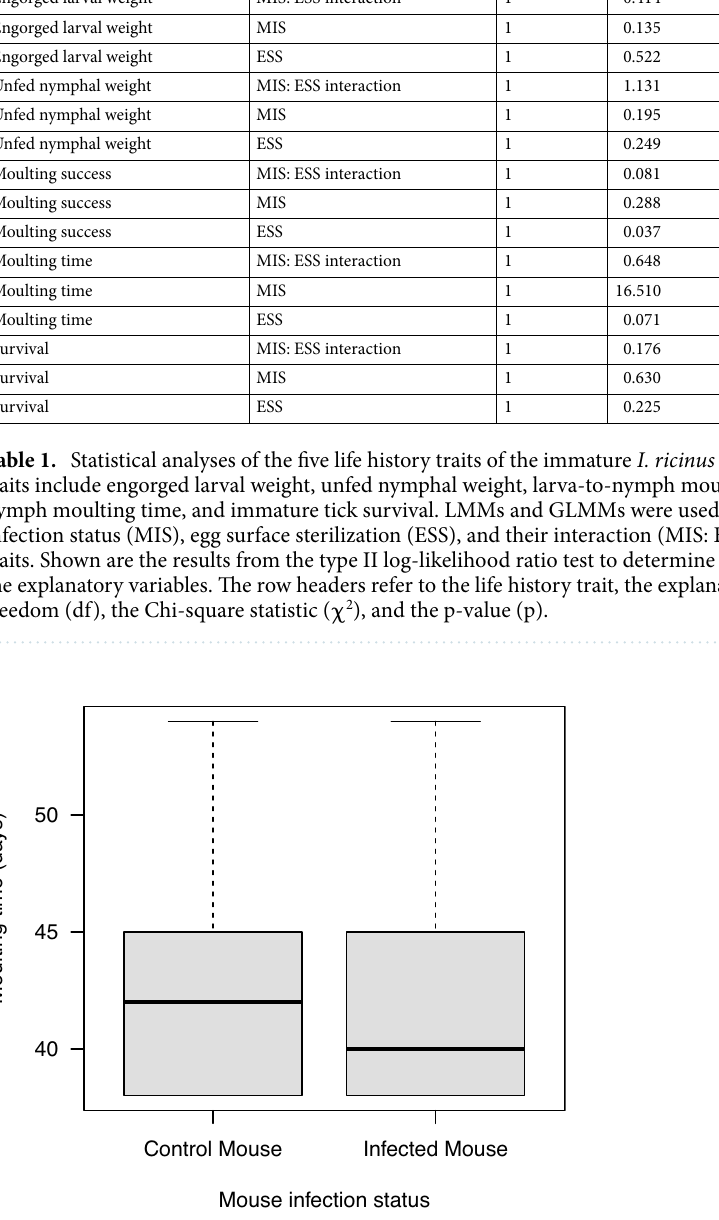
Figure 5. Ixodes rinicus larvae that feed on B. afzelii -infected mice have a faster larva-to-nymph moulting time compared to larvae that feed on uninfected control mice. The mean larva-to-nymph moulting time (days) for the larvae that fed on the B. afzelii -infected mice (mean = 41.3 days; median = 40 days; n = 776 ticks) was 1.0 day faster compared to the larvae that fed on the uninfected control mice (mean = 42.3 days; median = 42 days; n = 753 ticks), and this difference was highly significant (p < 0.0001). The larva-to-nymph moulting time was monitored over a period of 54 days after the start of the larval blood meal. The boxplots show the median (black line), 25th and 75th percentiles (edges of the box), and minimum and maximum values